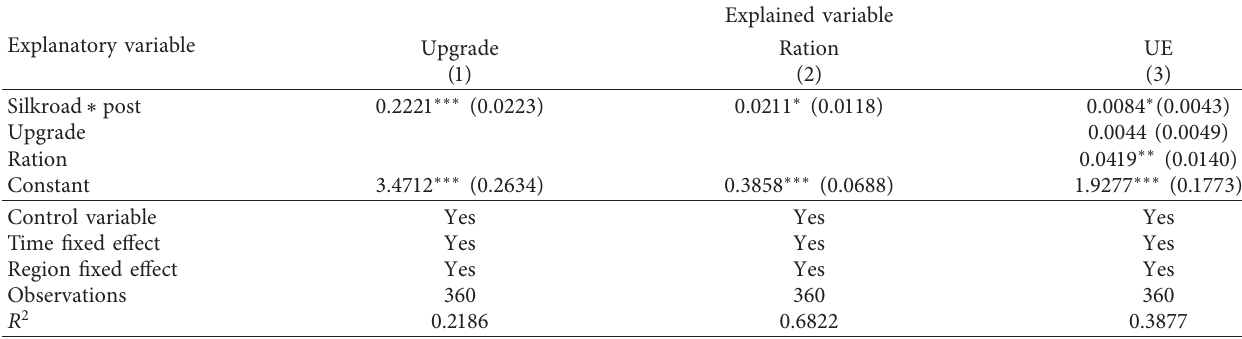
Table 7: Estimation results of multiple mediation